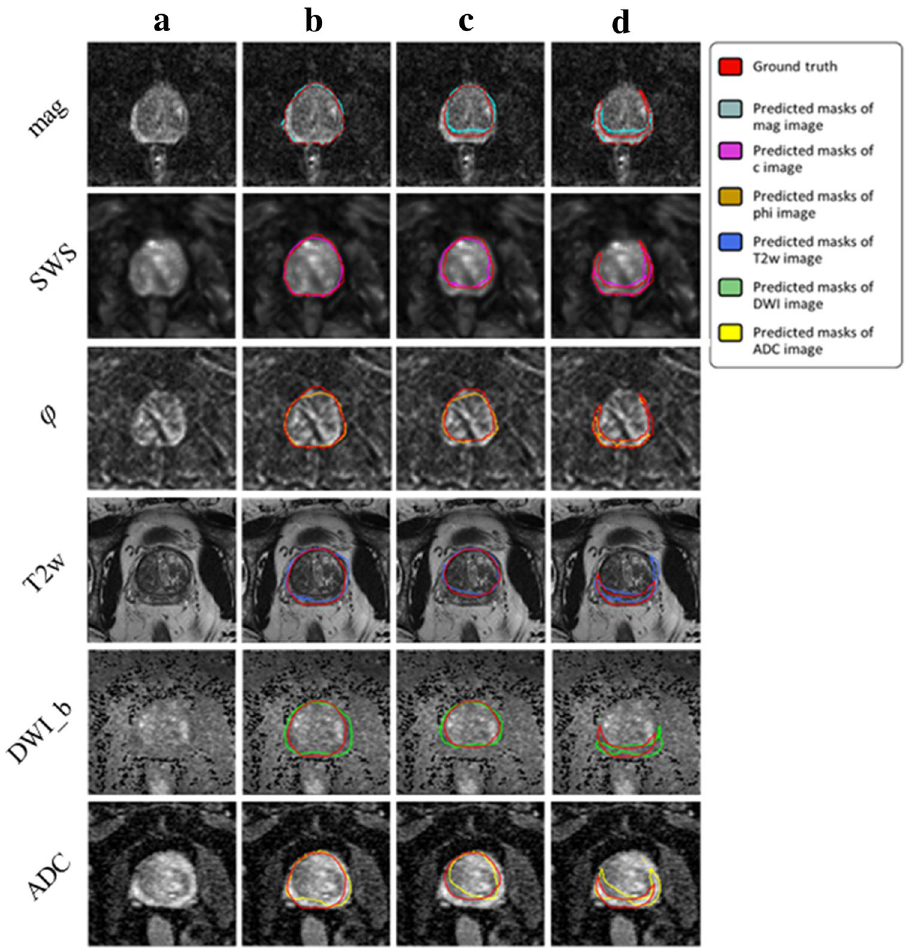
Figure 6. Examples of segmentation results achieved with the UM: first column ( a ) shows the original image, second ( b ), third ( c ) and forth column ( d ) show masks of prostate, central and peripheral zones, respectively.